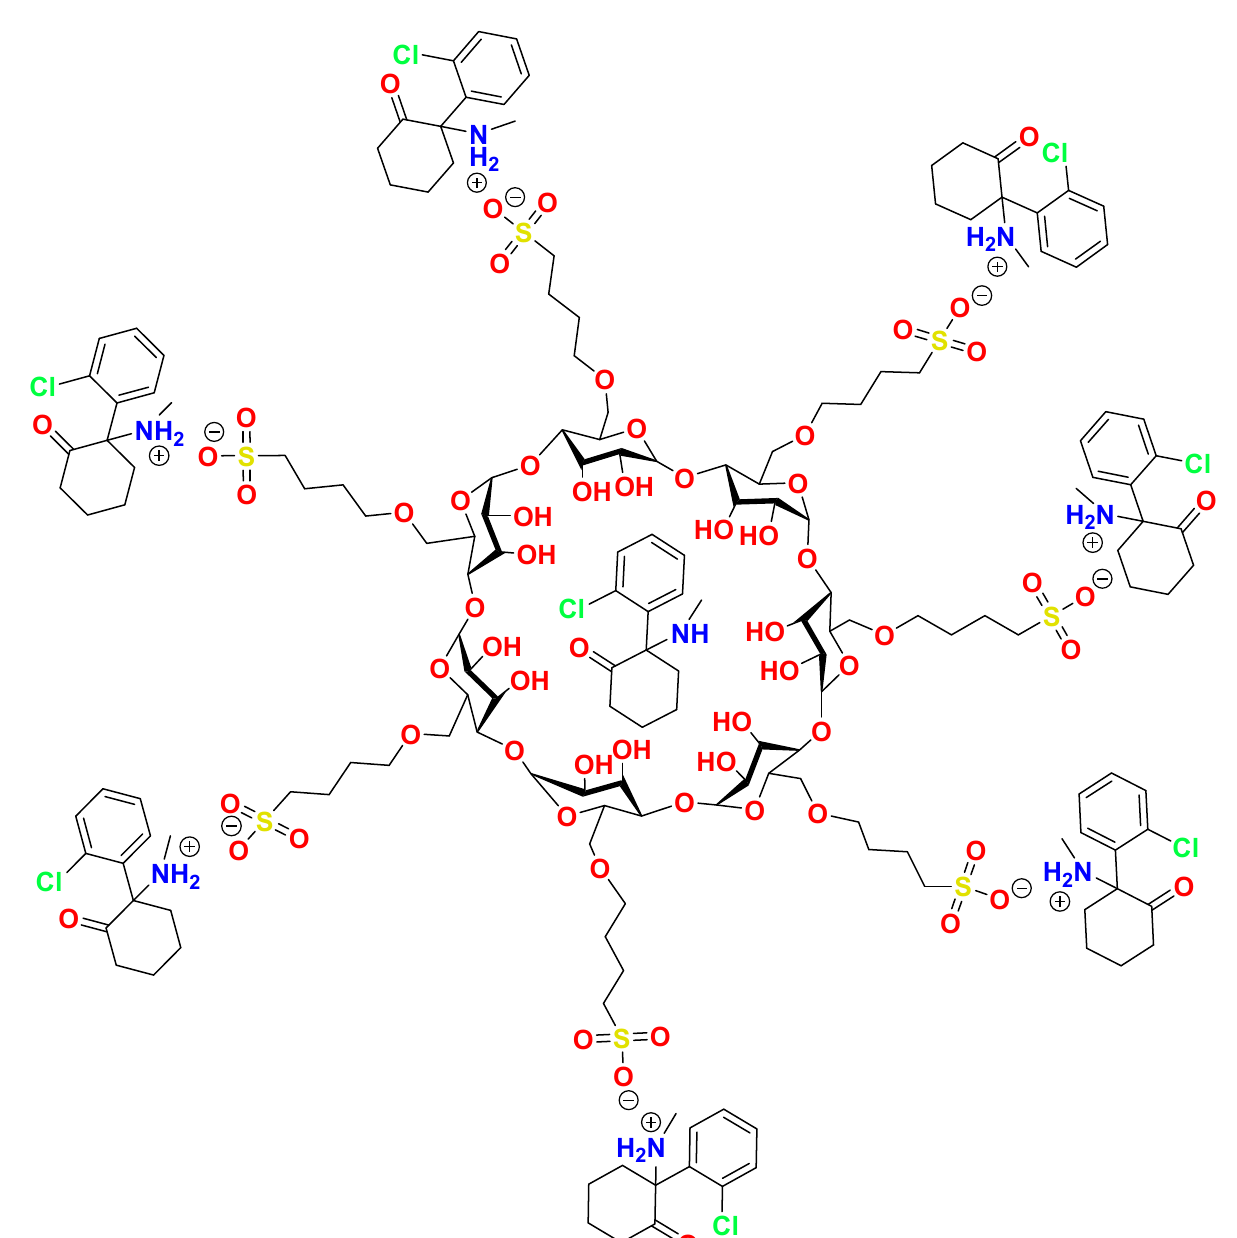
Figure 1. Proposed salt formation and complexation of ketamine with Captisol ® to form